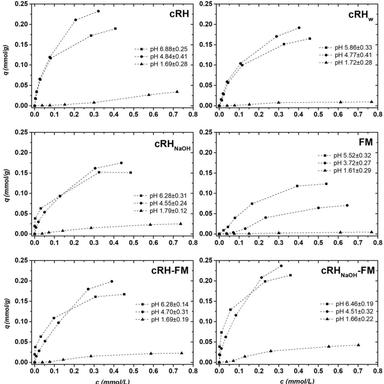
Copper ions adsorption isotherms of the different adsorbents at different equilibrium pH values. T = 20 ◦C, adsorbent mass 20 mg, volume 10 mL, metal ion concentration between 0 and 50 mg/L (0.787 mmol/L). The ions concentration is affected by an error lower than 4 % while that of the adsorption capacity is lower than 6 %. Lines are guides for the eyes.